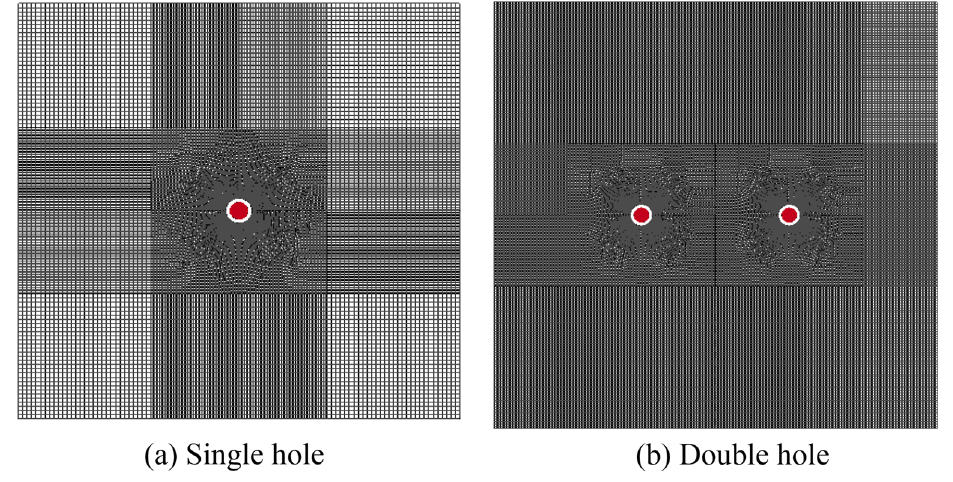
Figure 1. Model meshing.